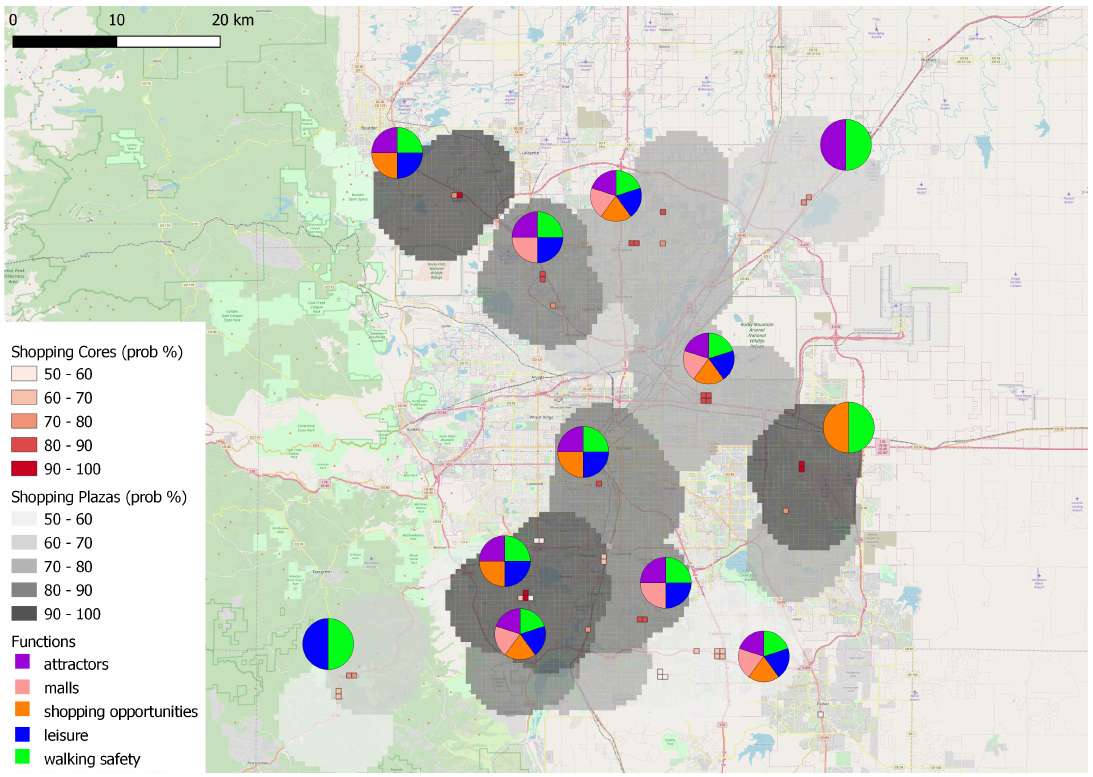
Figure 8. Results combining data-to-knowledge and knowledge-to-data fusion in the Denver metropolitan